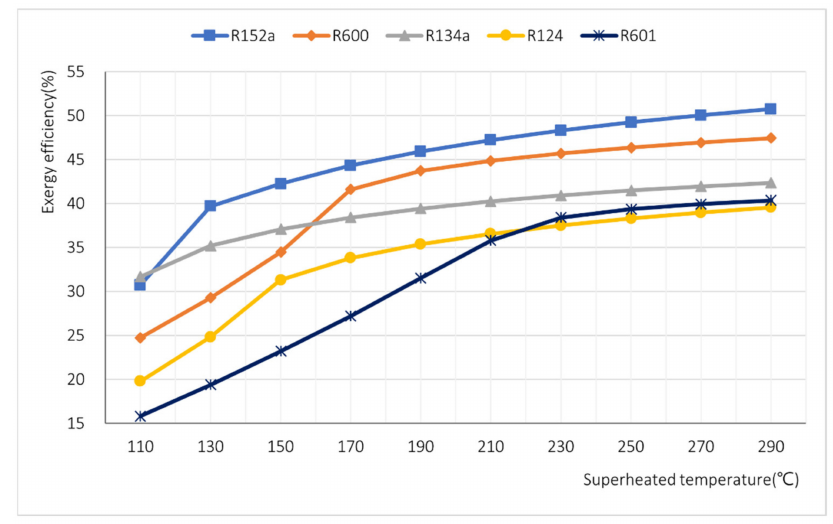
Figure 10. Exergy efficiency of ORC under different working